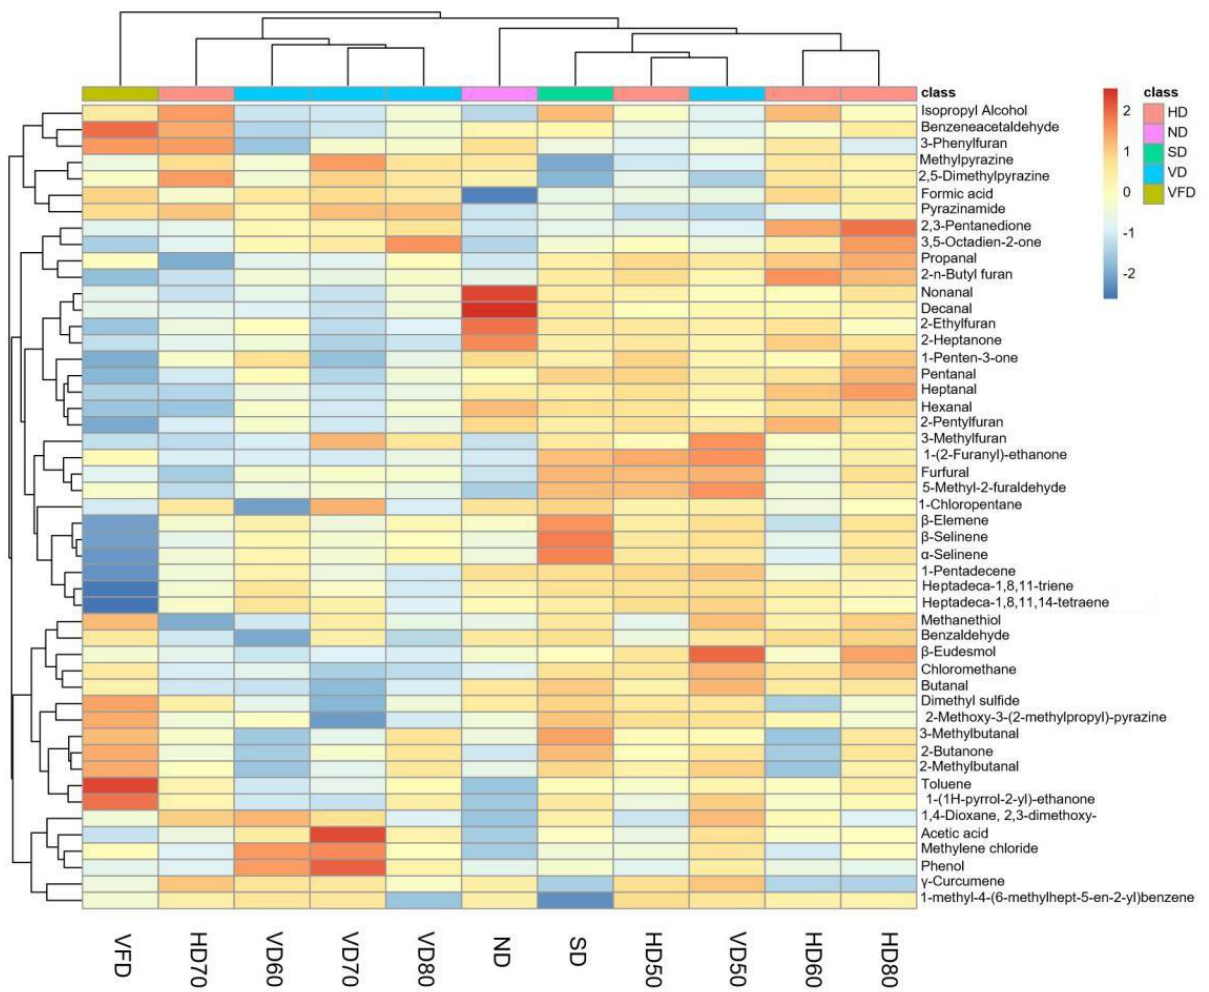
Figure 6. Heatmap of the volatile profiles of burdock root (BR). The legend on the left and bottom indicates the grouping of volatiles and sample groups, respectively (HD: hot air drying, ND: natural drying, SD: sunlight drying, VD: vacuum drying, VFD: vacuum freeze drying) ( n = 6).